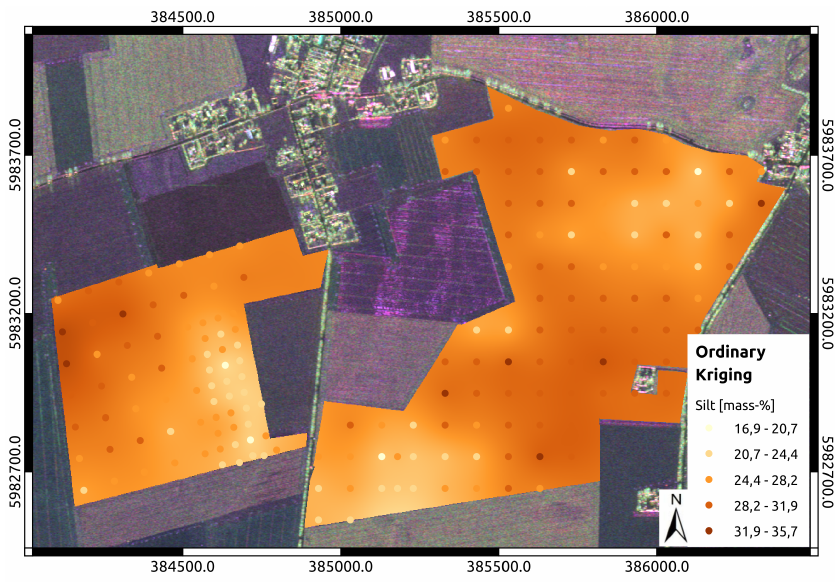
Figure 12. Spatial interpolated soil map for the texture class silt based on the OK approach. Circles display the sample locations and colors are scaled in the same color as background silt